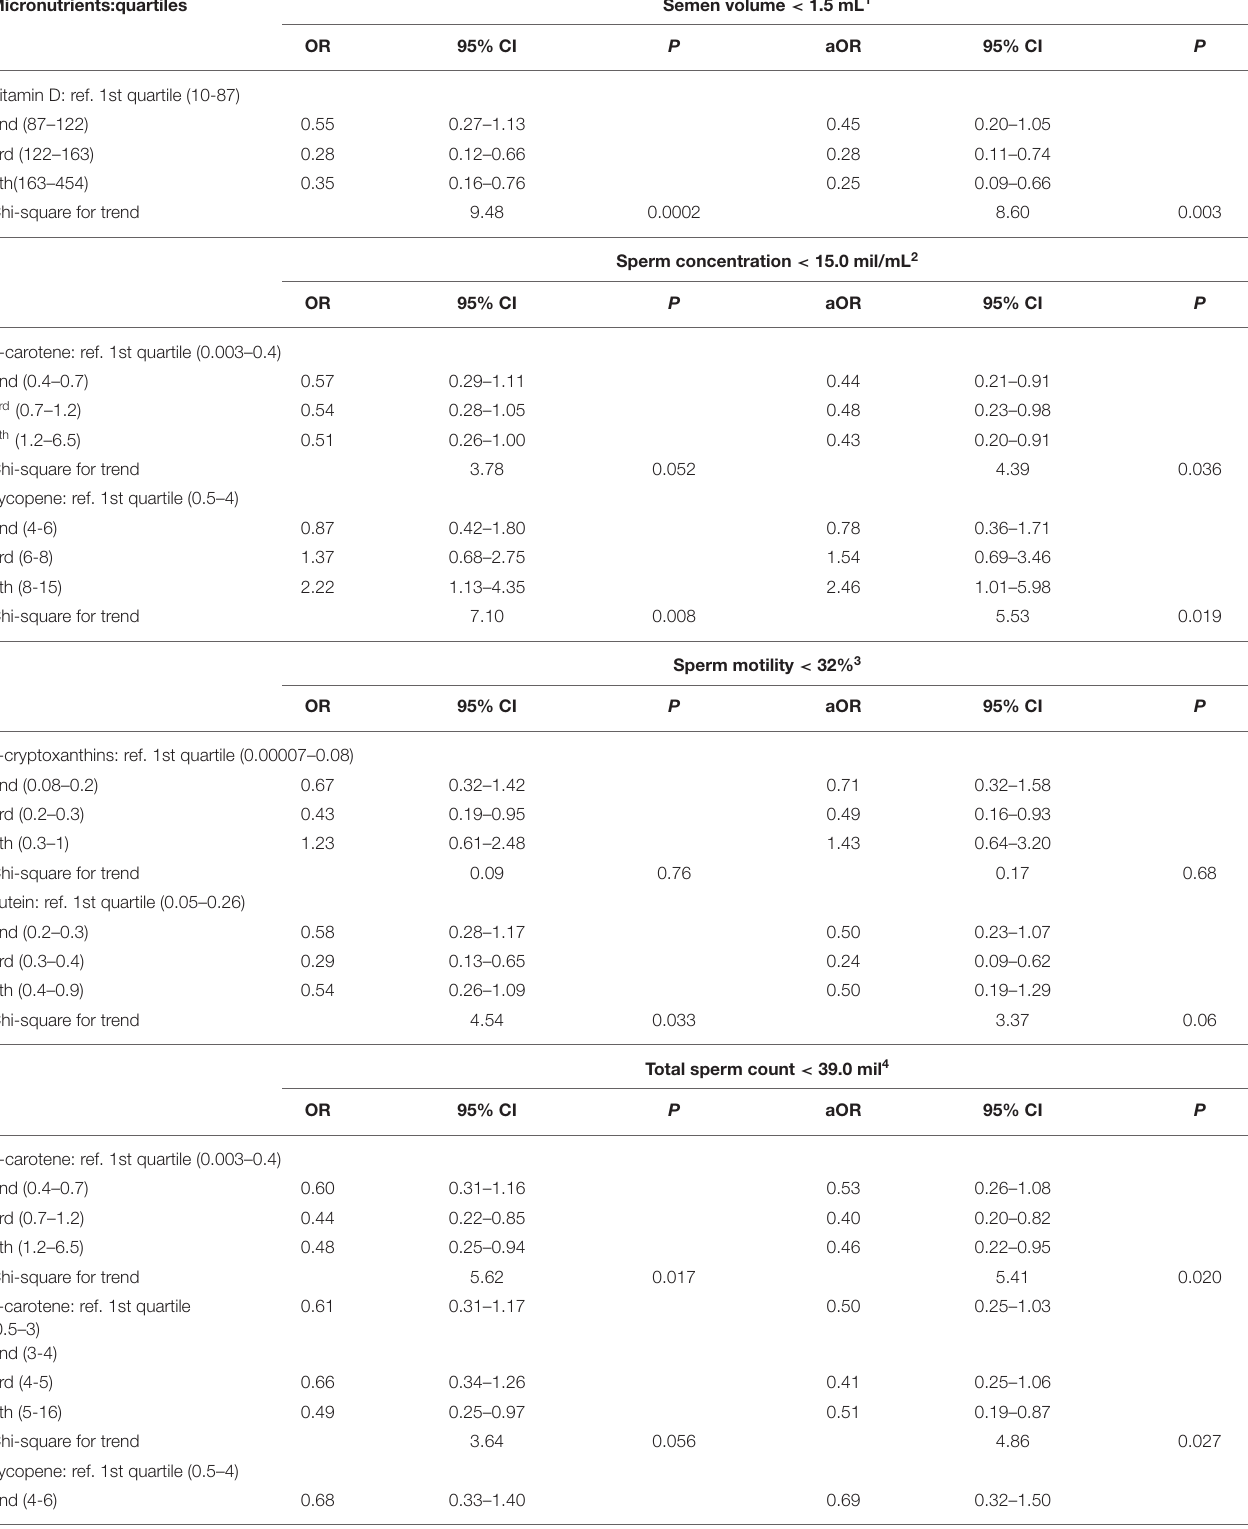
TABLE 3 | Crude and adjusted odds ratios and 95% confidence intervals for selected antioxidant intake.